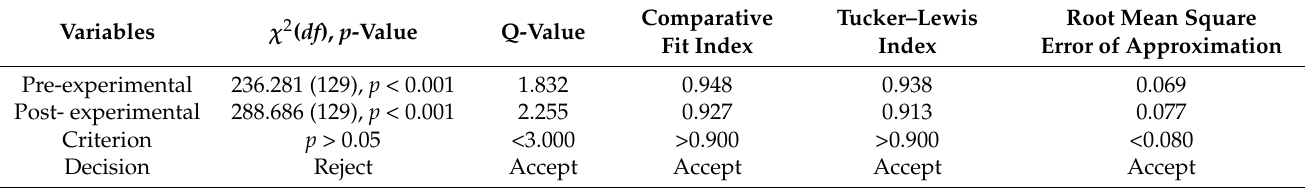
Table 2. Construct validity results via confirmatory factor analysis for the positive psychological capital test.